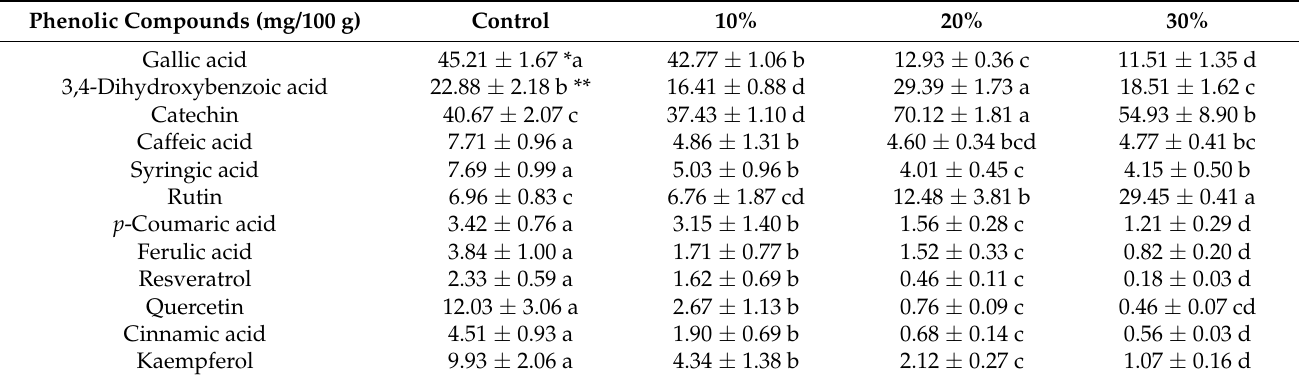
Table 2. Phenolic compounds of bread samples with coriander seed